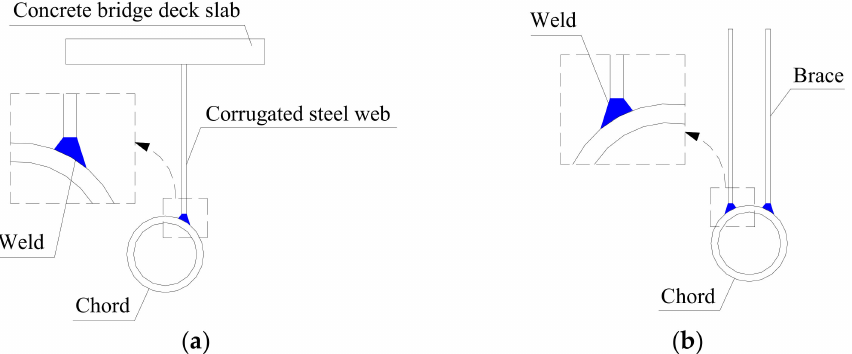
Figure 23. Comparison of welding details: ( a ) welding between the corrugated steel web and the chord; and ( b ) welding between the brace and the chord.